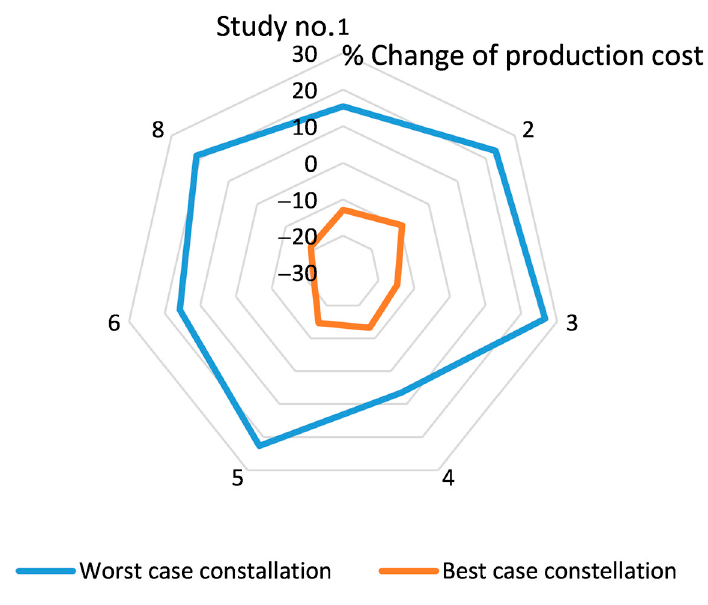
Figure 9. Change of production cost by using accumulated best- and worst-case economic parame- ters.